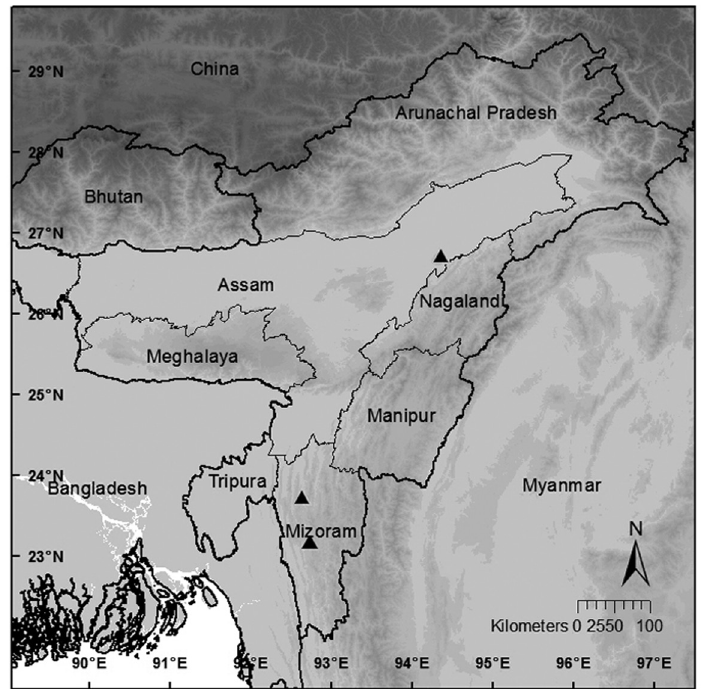
Fig. 12. Map showing the location of B. beddomei Hook.